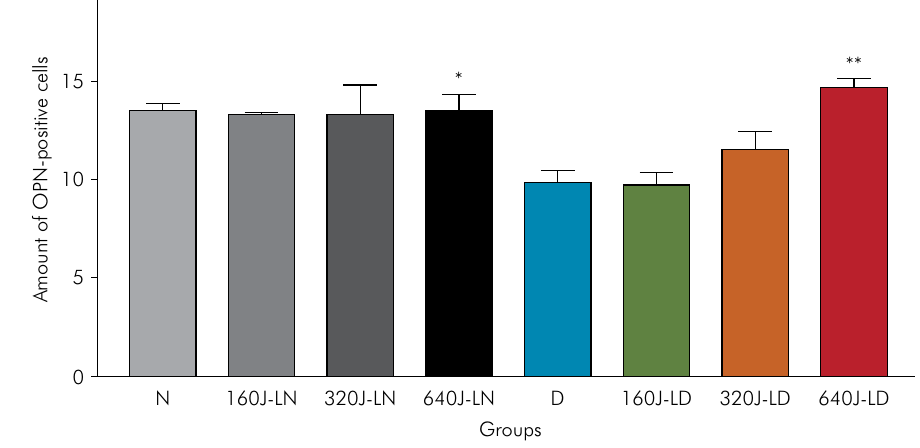
Figure 7. Quantitative analysis of osteopontin (OPN) expression in all studied groups. Values are expressed as mean ± standard